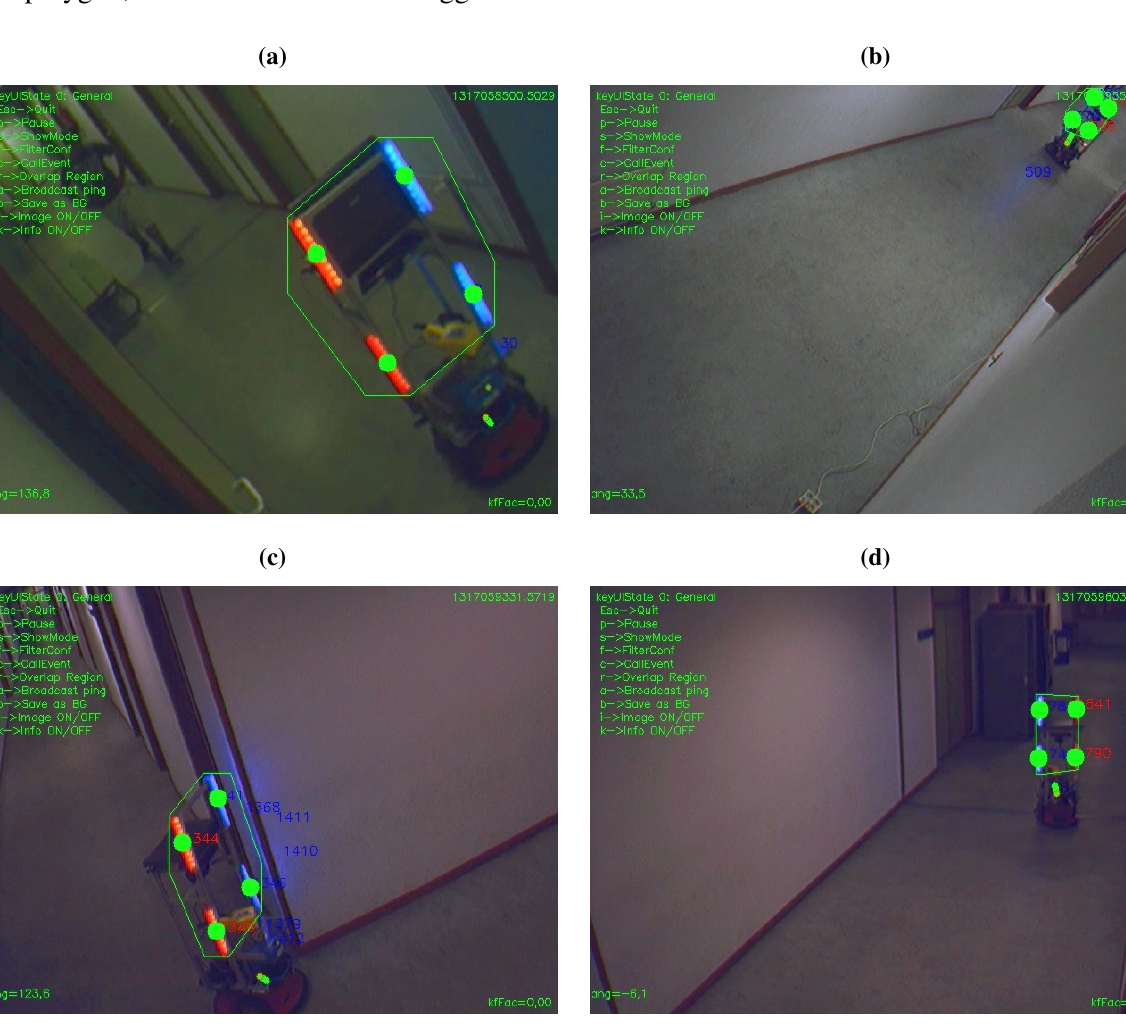
Figure 13. Example of camera captures from the experiment in Figure 12(c): ( a ) camera A, ( b ) camera C, ( c ) camera D, ( d ) camera E. The detected marker is rounded by a convex polygon, and each of its blobs is tagged with a